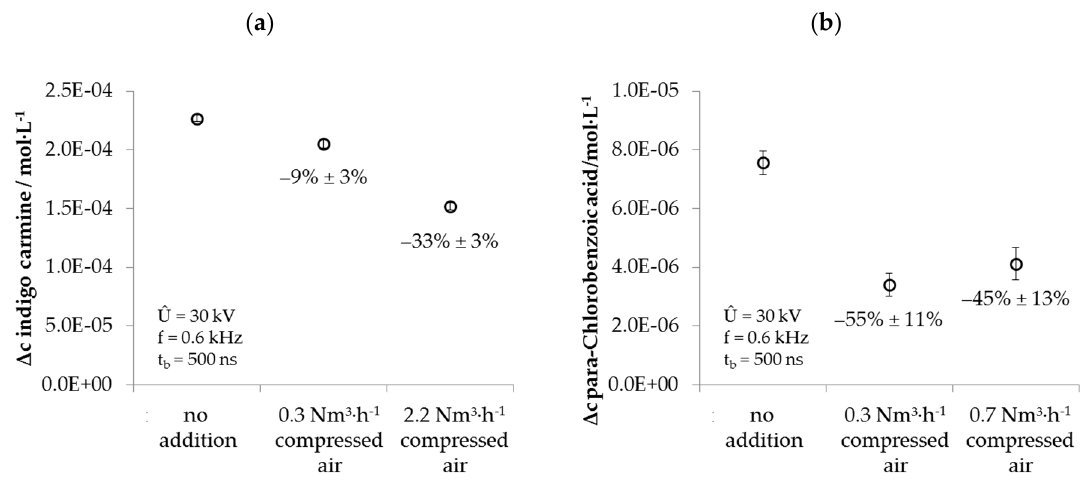
Figure 8. Decrease of ( a ) indigo carmine and ( b ) para-Chlorobenzoic acid concentration ( ∆ c ) without or with different compressed air supply to the reaction chamber.